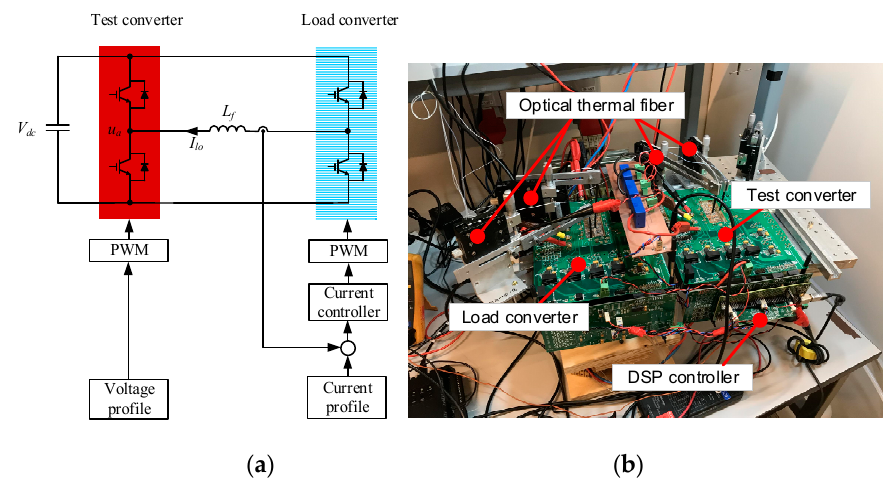
Figure 10. Experimental setup of H-bridge circuit. ( a ) Control block diagram. ( b ) Photo of experimental setup.